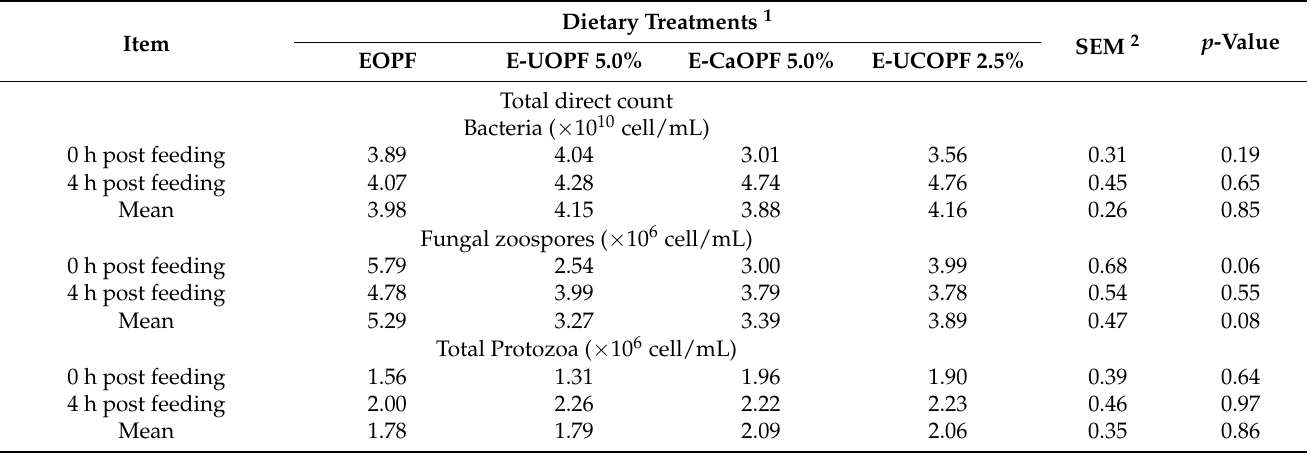
Table 7. Effect of ensiled oil palm fronds supplemented with urea-calcium hydroxide on rumen microbes in goats.